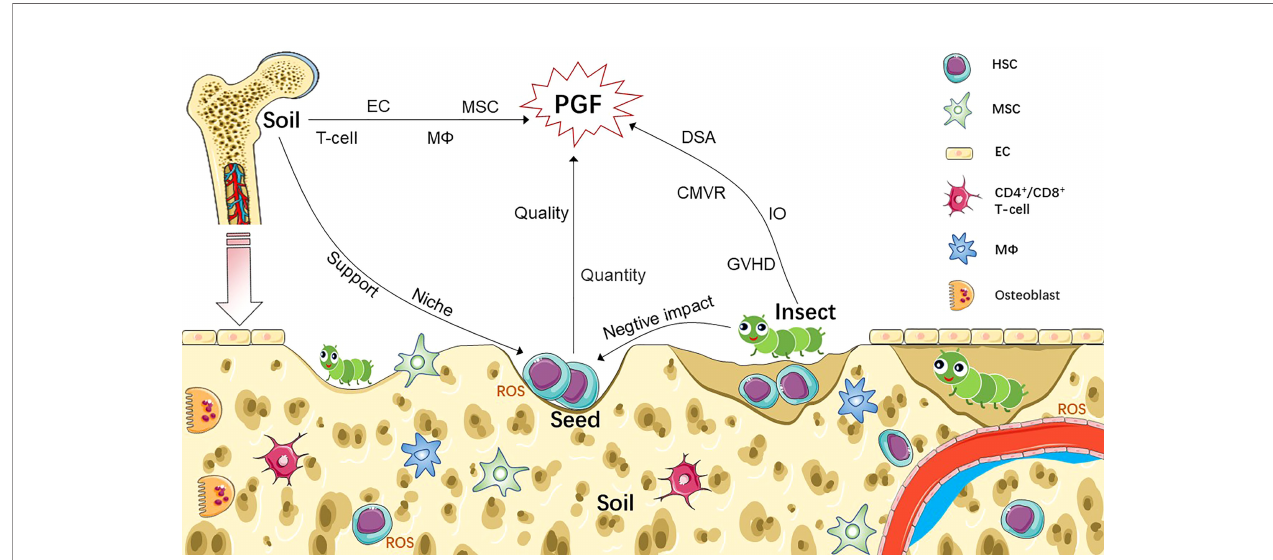
FIGURE 1 | Pathophysiology of PGF based on seed-soil-insect theory. Non-hematopoietic cells (such as MSC, EC) and HSC-derived cells (such as T-cell, macrophages) participate as part of the bone marrow niche, which not only regulate the function of HSC, but also involved in the pathogenesis of PGF after transplantation. Abnormal increased ROS is also contributing to the damage of both HSCs and BM niche of PGF patients. We compare CD34 + cells to seeds; bone marrow microenvironment to soil; and various factors associated with immune imbalance to insects, such as GVHD, DSA, CMVR and IO. Seeds, insects and soil interact to form a complex network that leads to PGF. Suf fi cient number of seeds with good quality and healthy soil are key to successful transplantation. Invading insects damage seeds and soil through knock-on effects, resulting in the occurrence of PGF. CMVR, cytomegalovirus reactivation; DSA, donor-speci fi c anti-human leukocyte antigen antibody; EC, endothelial cell; GVHD, graft-versus-host disease; HSC, hematopoietic stem cell; IO, iron overload; MSC, mesenchymal stem cell; M F , macrophage; PGF, poor graft function; ROS, reactive oxygen